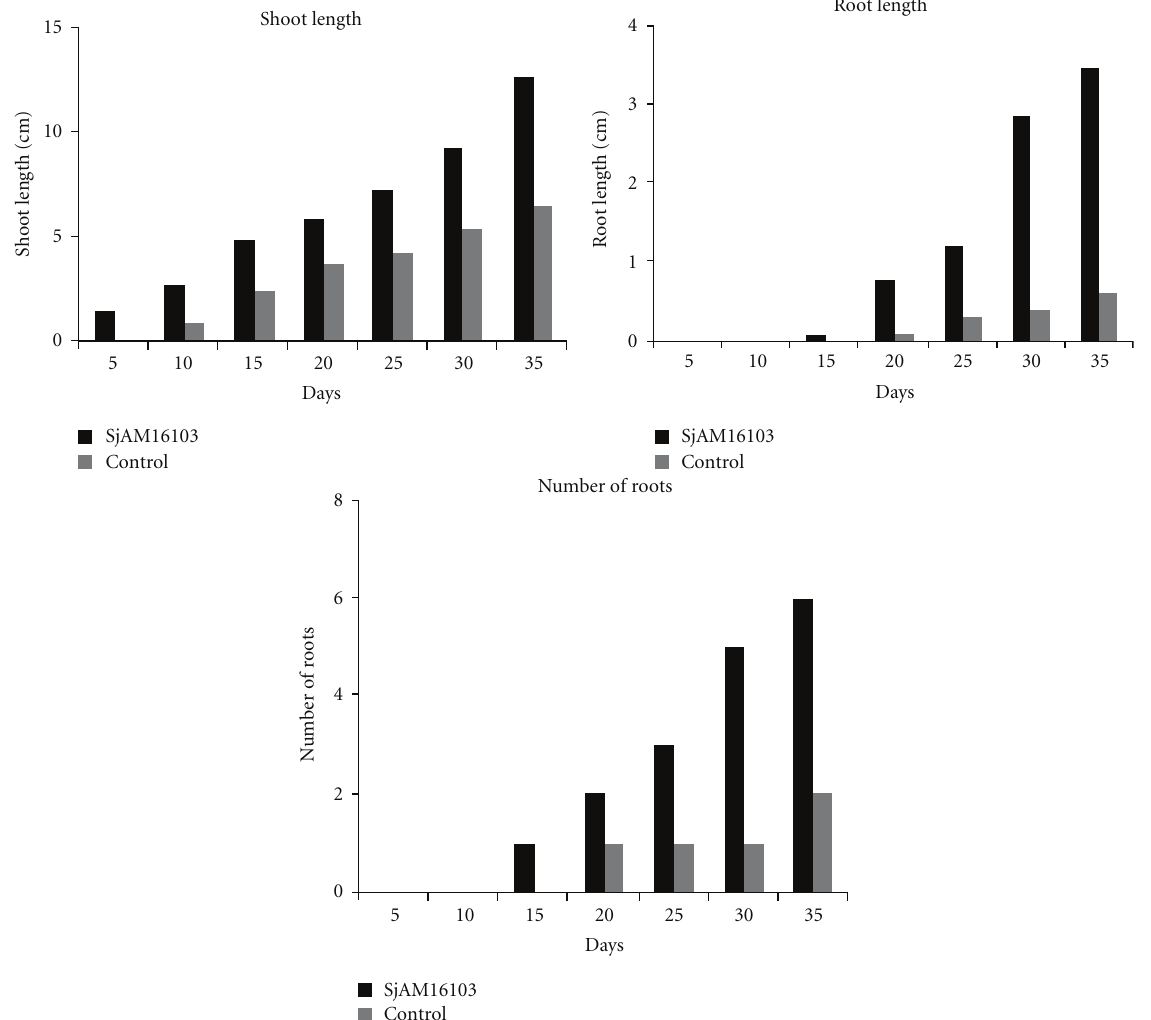
Figure 4: Inoculation of endophytic S. aquimarina SjAM16103 in B .